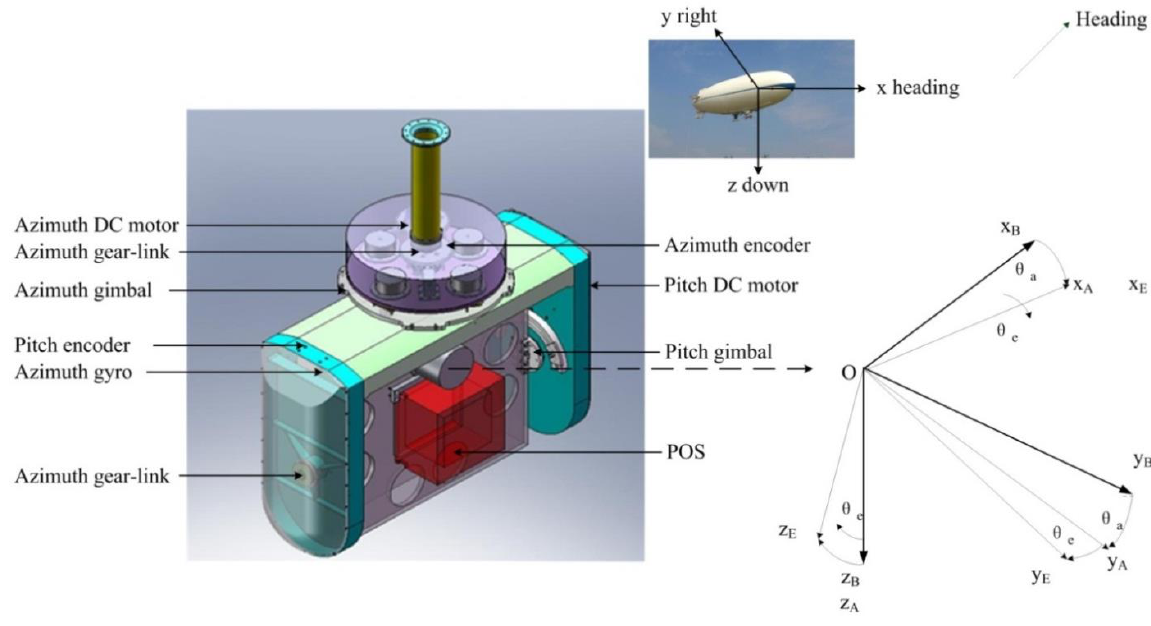
Figure 4. Three-dimensional CAD structural model of a two-axis ISP built using SOLIDWORKS ®